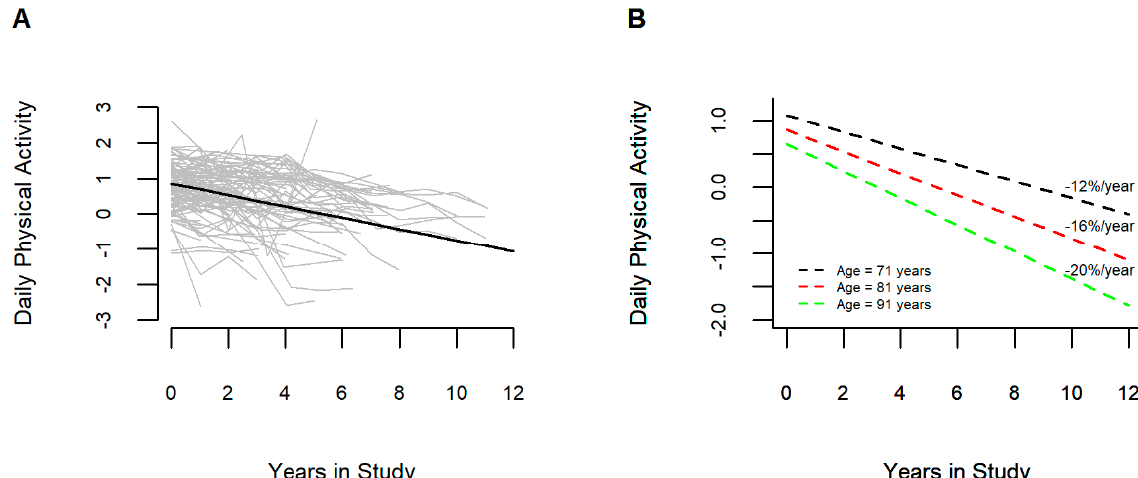
Figure 2. Trajectories of Declining Total Daily Physical Activity During this Study. ( A ) shows the crude paths of declining total daily physical activity (gray lines) and the average decline (solid black line) predicted by the linear mixed-effects model for a random sample of individual included in these analyses. ( B ) illustrates model derived trajectories of total daily physical activity for three average female participants with 15 years of education with different ages at baseline. Person-specific slopes of the rate of declining total daily physical activity for each individual are noted.